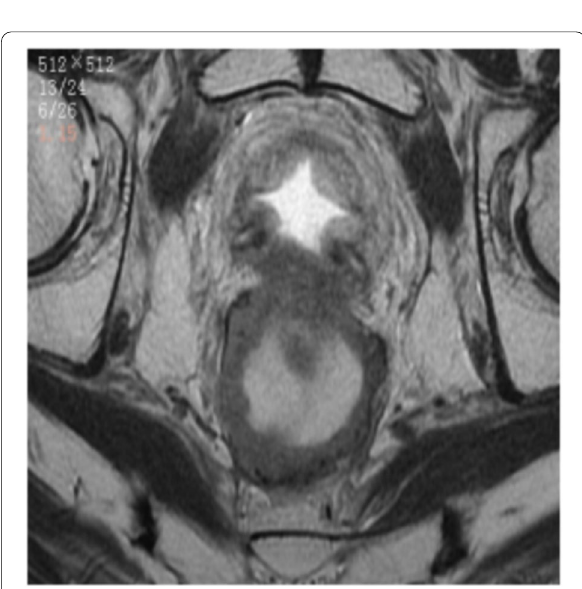
Fig. 3 MRI showing irregular circumferential thickening of the rectum wall at the surgical site